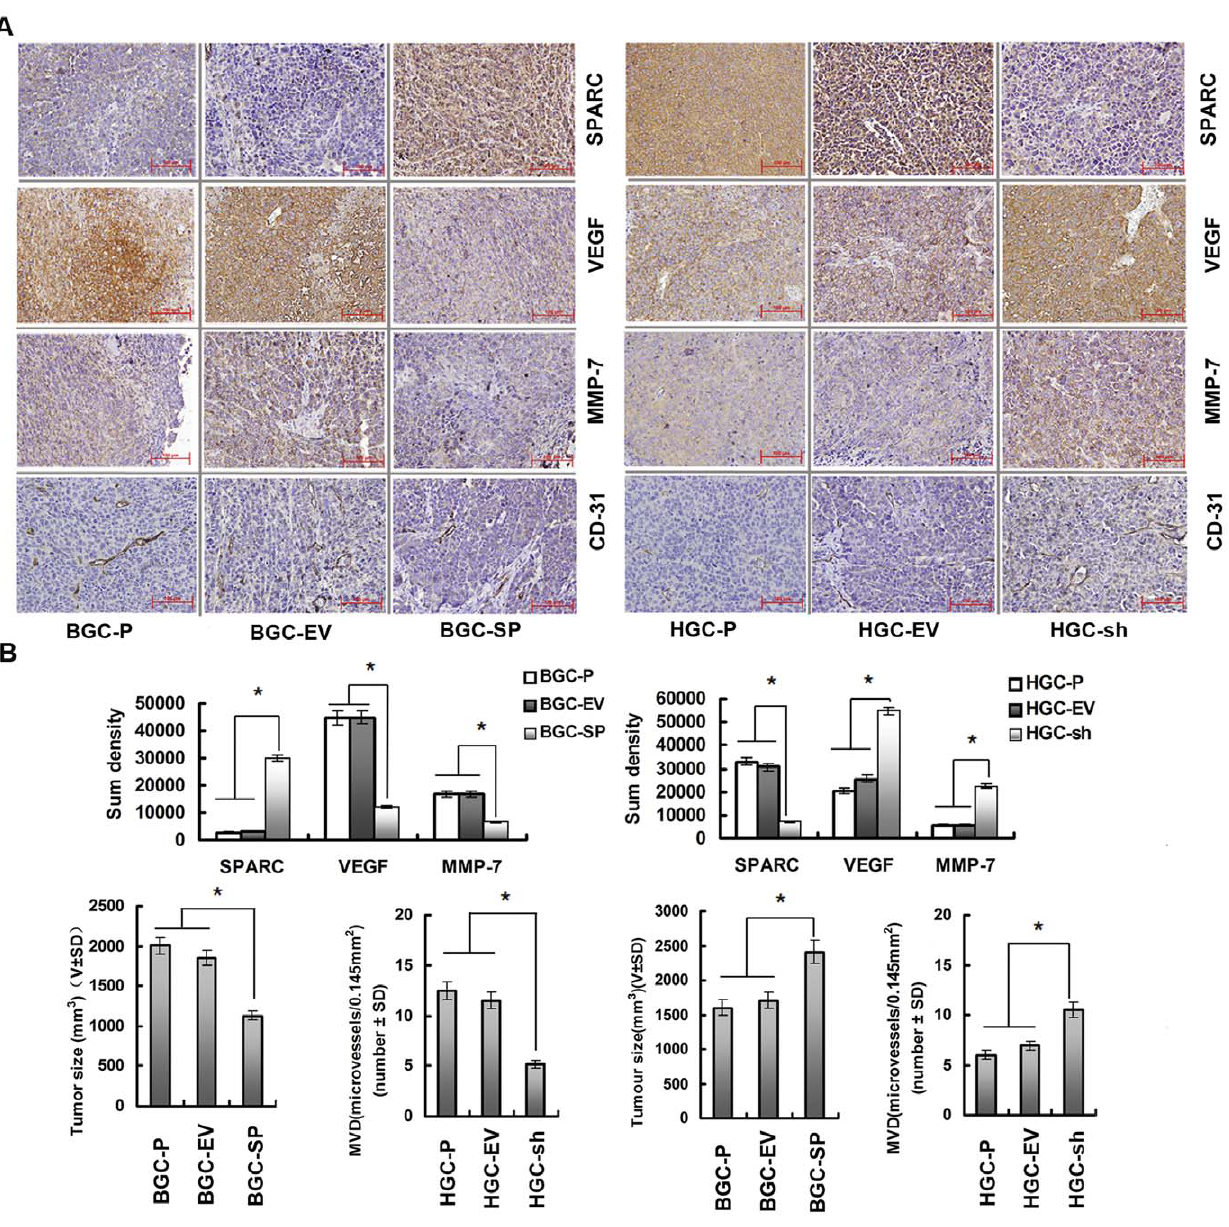
Figure 5. Overexpression of SPARC in gastric cancer cells inhibits tumour development and vascularisation in nude mice. ( A ) Paraffin-embedded sections of xenografted tumours were used for immunohistochemical analysis of SPARC, MMP-7, VEGF, and CD-31. ( B ) Sections were stained with a monoclonal antibody against human SPARC, VEGF, MMP-7. Sum densities were calculated and analyzed by IPP 6.0. Columns are means ( 6 s.d.) of quadruplicate determinations from six mice in each group. *P , 0.05, significant difference from control cells. ( C ) MVD in tumour tissues was quantified by counting CD31-positive areas in each microscopic field of view. Columns are means ( 6 s.d.) of quadruplicate determinations from six mice in each group. *P , 0.05, significant difference from control cells. The tumour volume was calculated (volume = width 2 6 length 6 0.52). The volume of tumours at the 50th day is indicated by the mean values ( 6 s.d.) of six mice in each group, *P , 0.05, significant difference from control